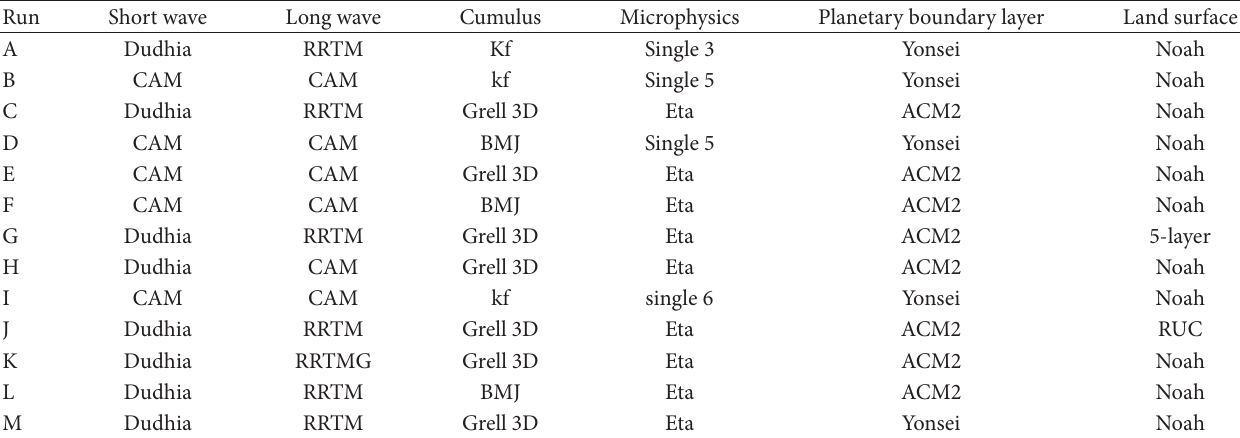
Figure 3: The total rainfall from TRMM data for each month of the short rains, (a) October, (b) November, and (c) December, shows the transition of the rainy season over the region with the most consistent cover in November. Table 1: The combinations of physics options used for each run. The base combinations are runs A–C. For further information on each option please see references [35, 37, 38,